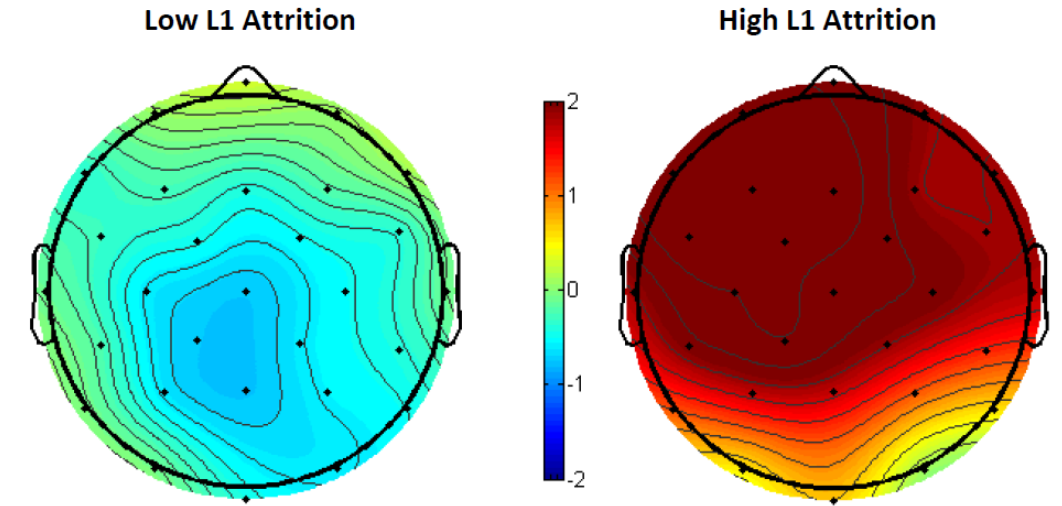
Figure 13. The 300 – 500-ms voltage maps of the L1 translation lexical relatedness priming effect (lexically unrelated translations – lexically related translations) in low/high L1 attrition bilinguals.